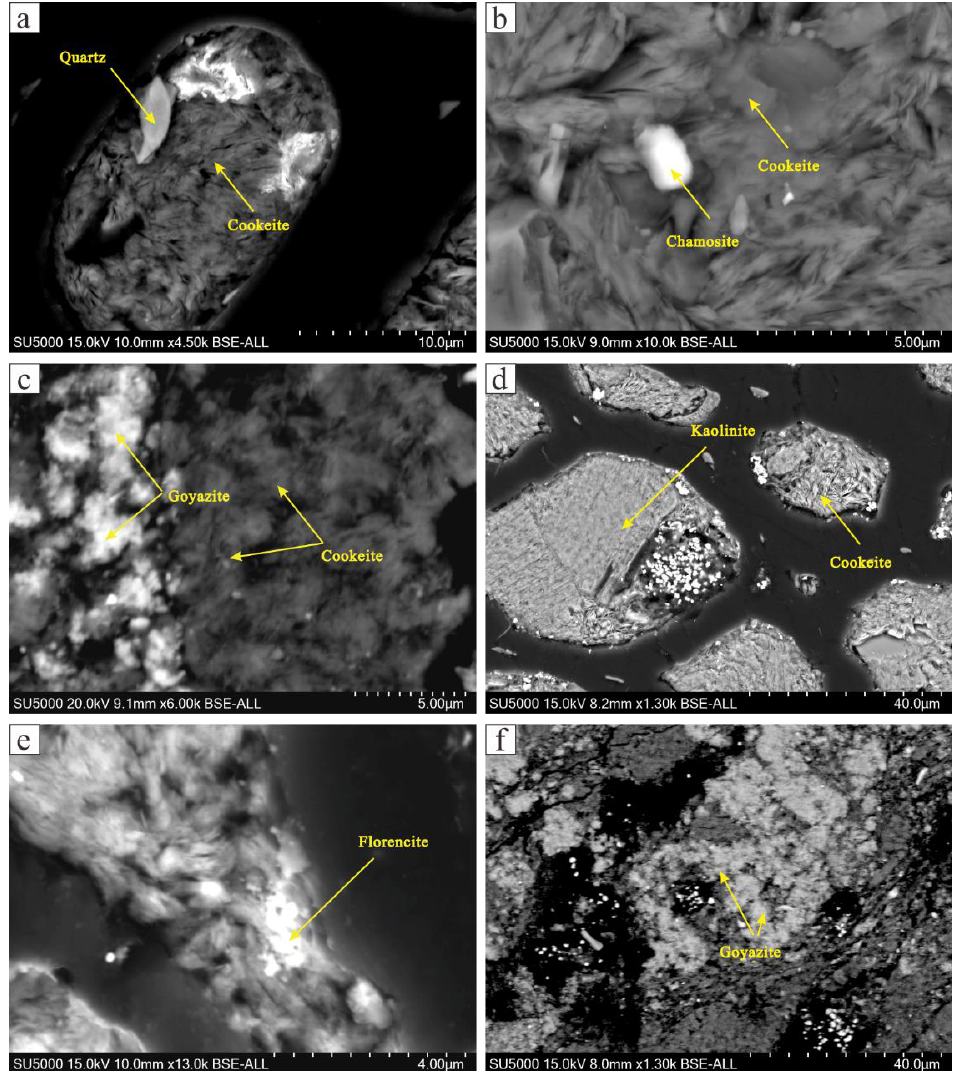
Figure 8. SEM back-scattered images of minerals in the sample. coexisting cookeite and quartz in cell-infilling ( a ); pillar-like chamosite in the cookeite ( b ); coexisting cookeite and goyazite ( c ); cookeite and kaolinite in cell-infillings ( d ); florencite in the clay matrix ( e ); goyazite in kaolinite matrix ( f ). EDS data are as in Supplementary Table S2.